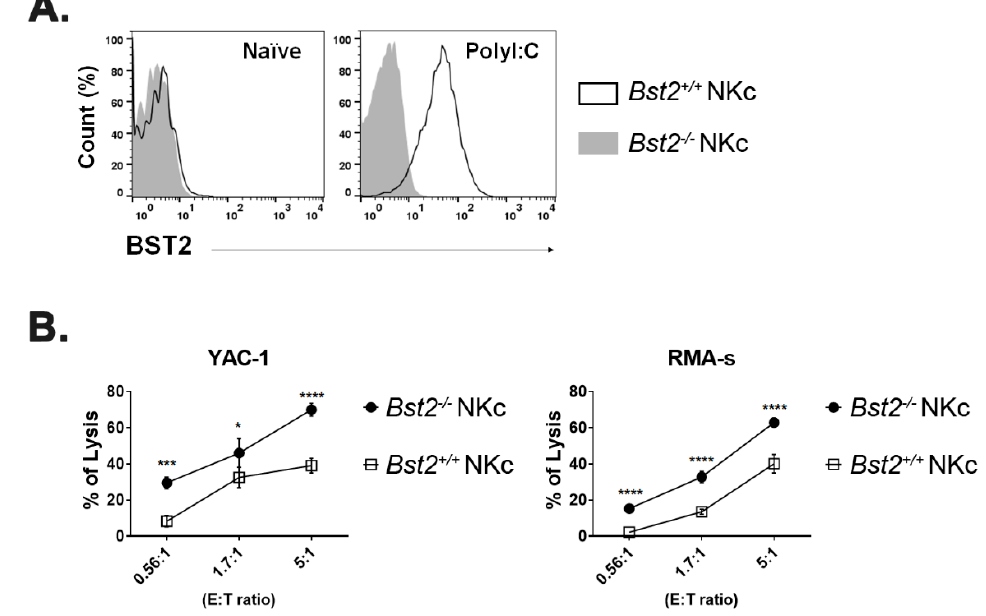
Figure 1. PolyI:C stimulated Bst2 -/- NK cells have a higher cytotoxicity to tumor cells than Bst2 +/+ NK cells. B6-origin Bst2 wildtype (+/+) and Bst2 knockout (-/-) mice were intraperitoneally injected with polyI:C. At 16 hrs after injections, splenic NK cells were isolated using DX-5 microbeads. ( A ) Bst2 +/+ and Bst2 -/- NK cells were stained with anti-BST2 antibody and analyzed by flow cytometry. NK1.1 + TCR β - cells were indicated as NK cells. Data are representative of two independent experiments. ( B ) Calcein-AM stained target cells (YAC-1 and RMA-S) were co-cultured with Bst2 +/+ and Bst2 -/- NK cells for 4 hrs at 37 ◦ C in a humidified incubator. Released calcein was measured by SpectraMAX with excitation/emission wavelengths at 485 nm/535 nm. Graphs showed a mean ± S.D. ( n = 3 per group). Data are representative of three independent experiments. (*, p < 0.05; ***, p < 0.001; ****, p < 0.0001).